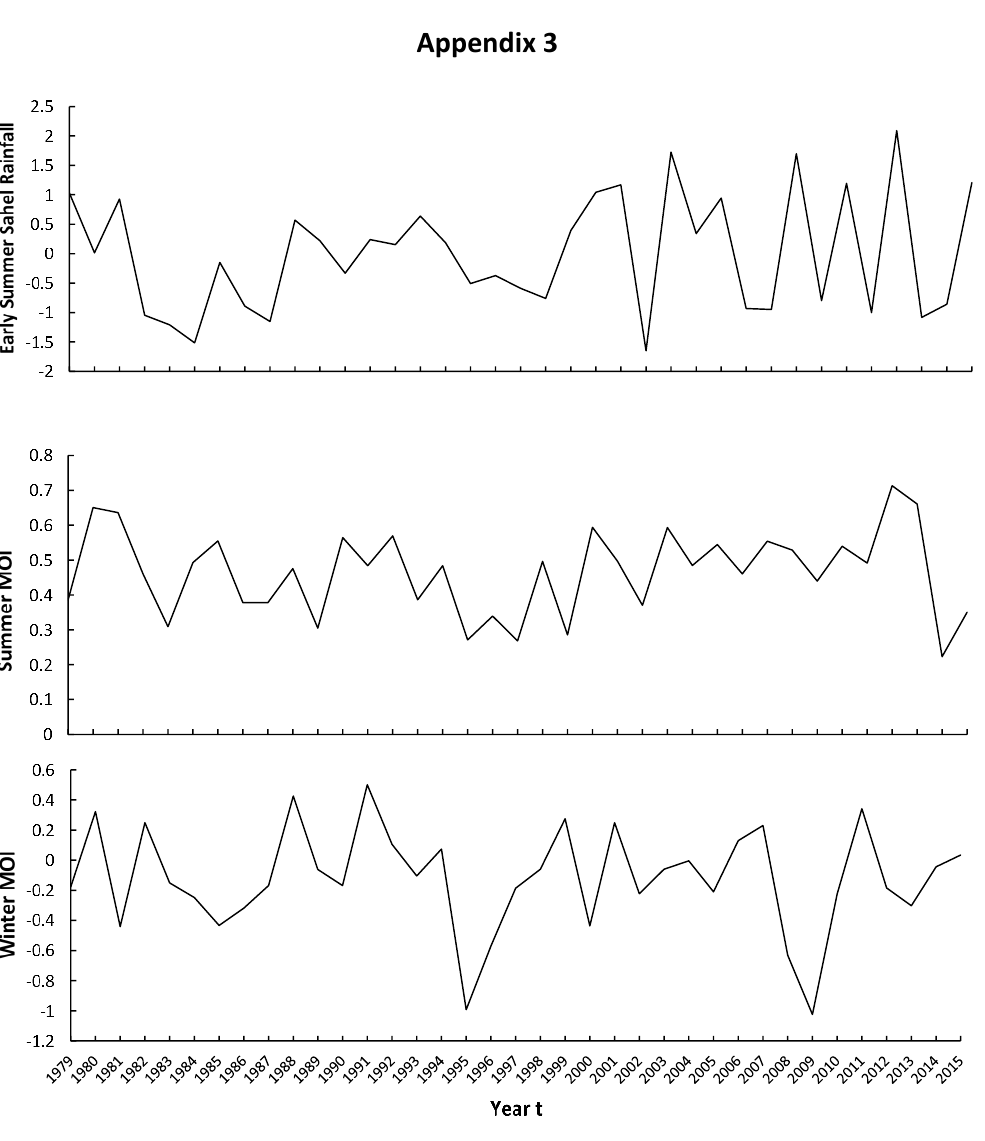
Figure S1 : Annual variation in the three considered climate indices during the study